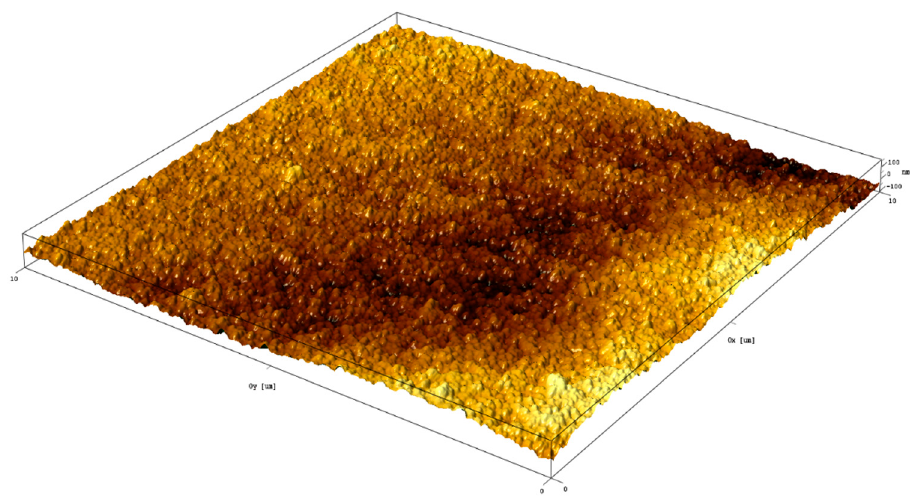
Figure 2. AFM 3D image of TiO 2 –rGO film.